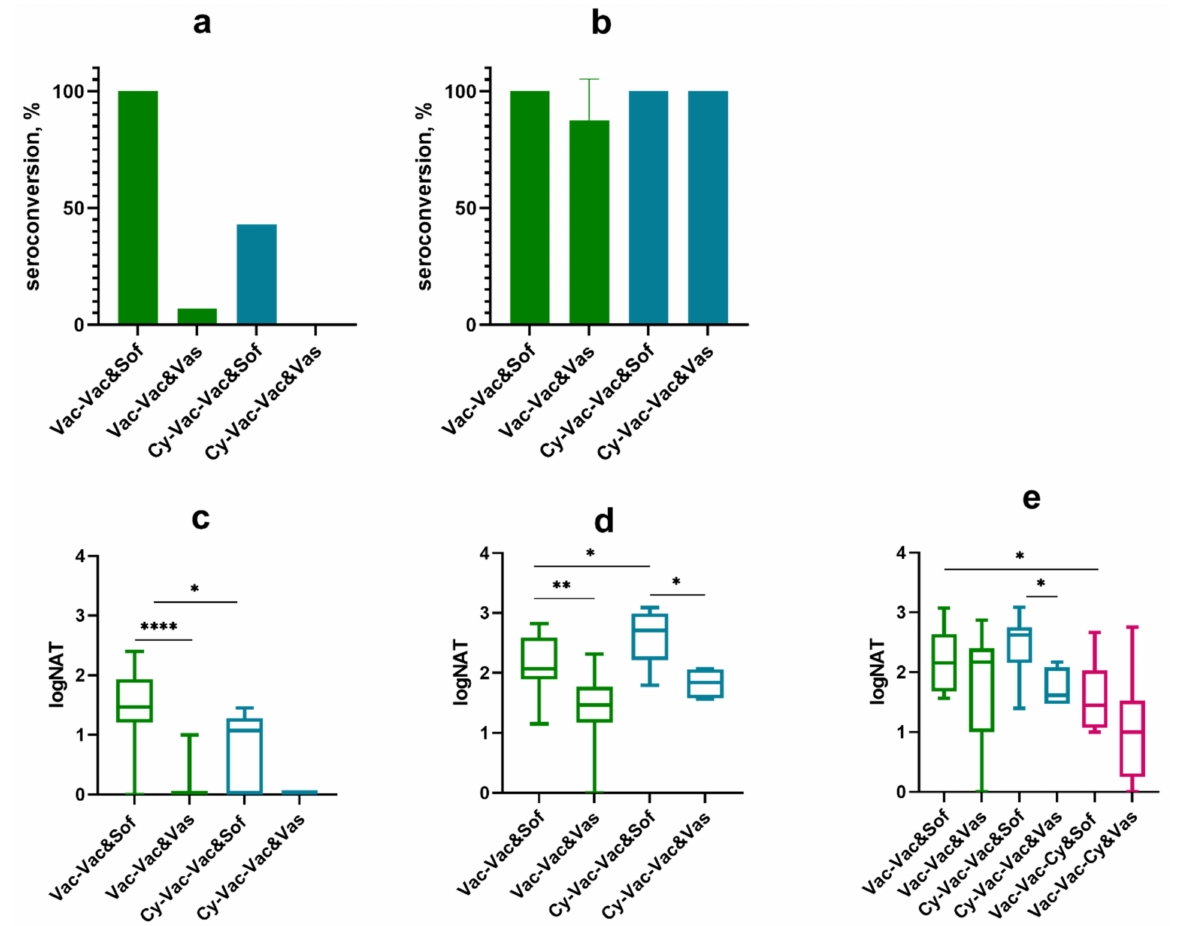
Figure 3. Seroconversion and levels of neutralizing antibodies (NAb) against TBEV vaccine strain Sofjin (&Sof) and the challenge strain Vasilchenko (&Vas) in sera of Cy-treated mice (low-dose scheme). ( a ) Seroconversion rate after the first vaccine dose and ( b ) after the second vaccine dose. NAb titers were measured in sera of mice ( c ) 10 days after the first vaccine dose, ( d ) 10 days after the second vaccine dose, and ( e ) one day after the challenge with Vas TBEV strain. The control group Vac-Vac did not receive Cy treatment (green); Cy-Vac-Vac group was treated with Cy before the first vaccine dose (blue); Vac-Vac-Cy was treated with Cy after two-dose vaccination and immediately before the challenge (pink). N = 7–8 mice per group. In ( a – d ) Vac-Vac group includes the data for Vac-Vac and Vac-Vac-Cy groups, since at this stage of the experiment they received identical treatment. * p < 0.05; ** p < 0.01; **** p < 0.0001.in Mann-Whitney test. Box plots indicate median and